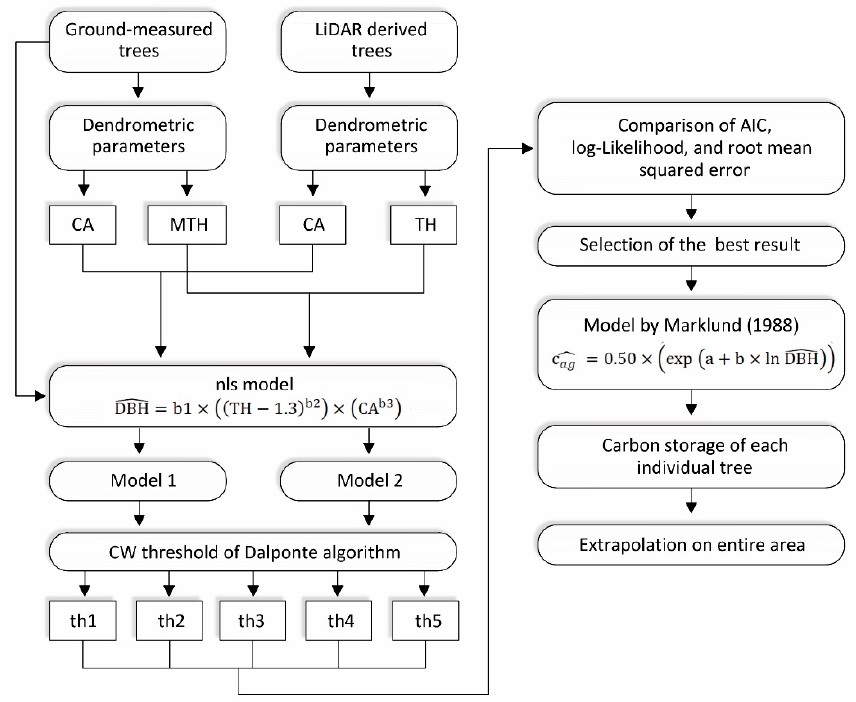
Figure 6. Workflow for DBH and carbon modeling (CA: canopy area, MTH: measured tree height, TH: LiDAR tree height, CW: canopy width, DBH: diameter outside bark at breast height, th: threshold, AIC: Akaike’s information criterion).